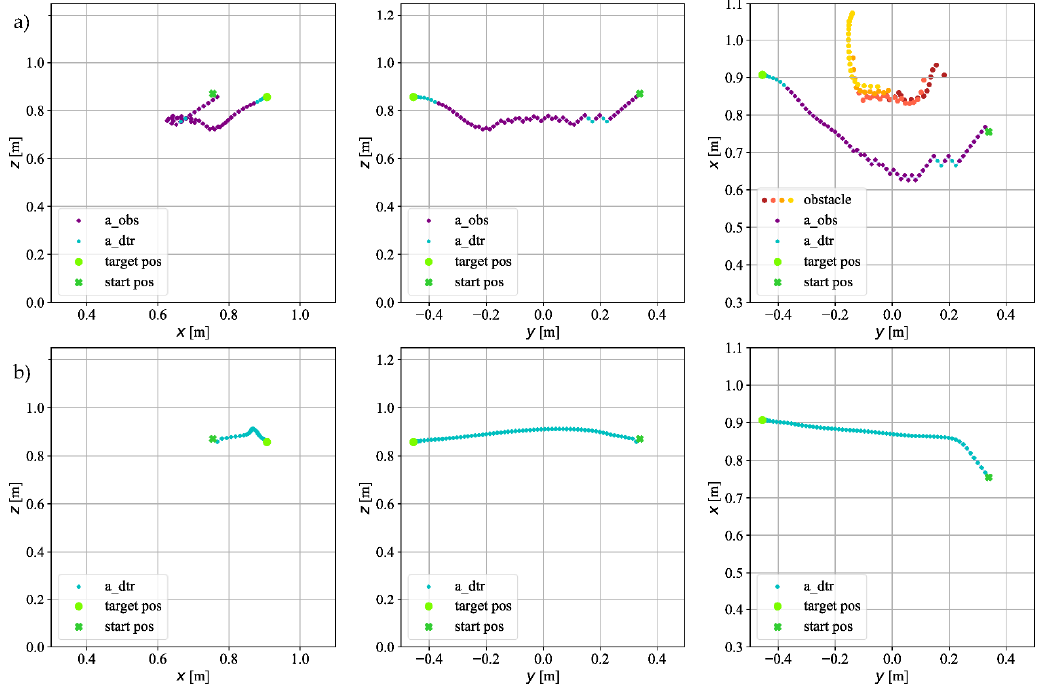
Figure 12. The trajectory on which the TCP of the robot moved in experimental research for goal point 𝑔 4 : ( a ) with an obstacle; ( b ) without an obstacle.